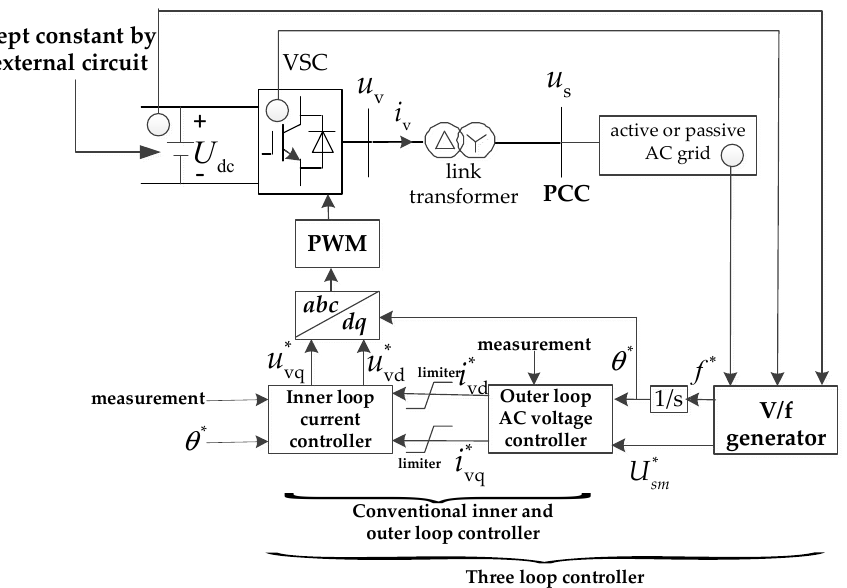
Figure 2. Three-loop controller diagram of the V θ type grid-forming nonsynchronous-machine